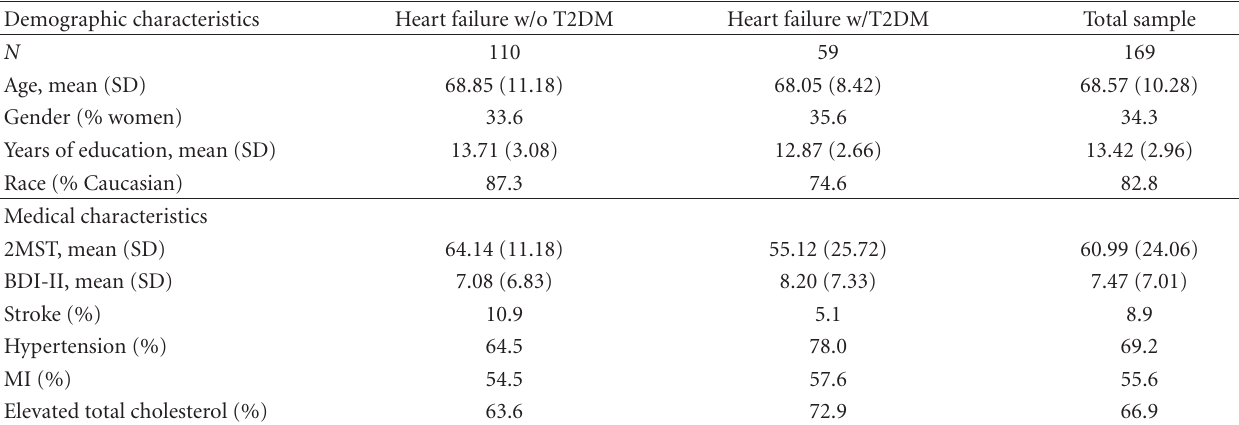
Table 1: Demographic and medical characteristics of older heart failure adults with and without type-2 diabetes mellitus (T2DM). Demographic